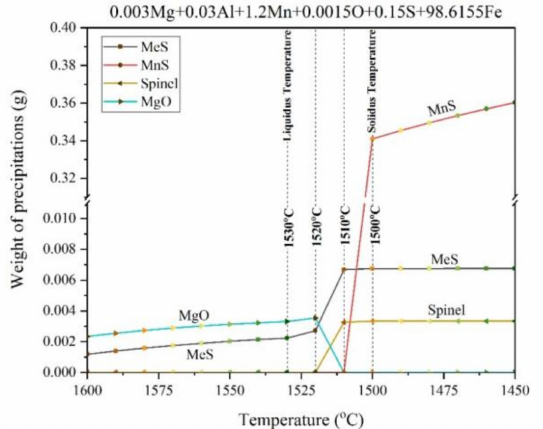
Figure 9. Equilibrium precipitation of inclusions during solidification for Mg-Al-Mn-O-S molten steel (MeS: Mg 0.9 Mn 0.1 S, Spinel: MgAl 2 O 4 ).